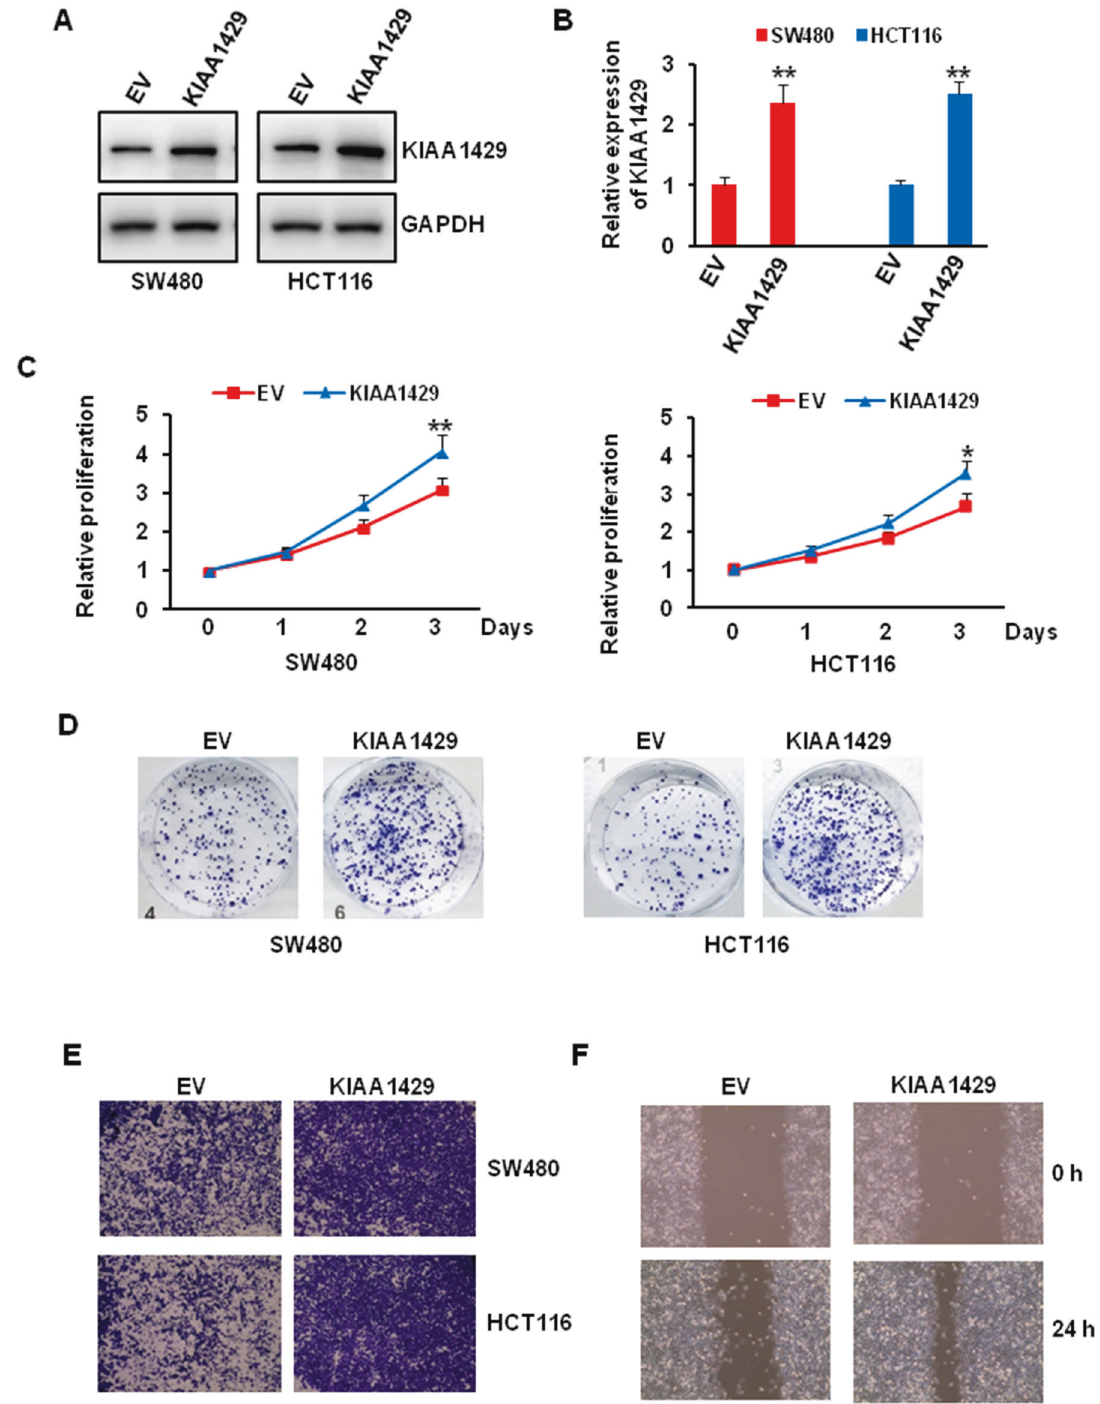
Fig. 4 Effect of KIAA1429 overexpression on cells proliferation, colony formation, and migration. A , B The overexpression ef fi ciency of KIAA1429 in colorectal cancer cells was detected by western blotting ( A ) and QRT-PCR ( B ). ** P < 0.01. C The proliferation of SW480 and HCT116 cells after KIAA1429 overexpression over 3 days was measured using CCK-8 assay. * P < 0.05, ** P < 0.01. D The growth of SW480 and HCT116 cells over 14 days after KIAA1429 overexpression was measured using colony formation assay. E Transwell migration assay of SW480 and HCT116 cells after KIAA1429 overexpression. F Wound healing assay of SW480 cells after KIAA1429